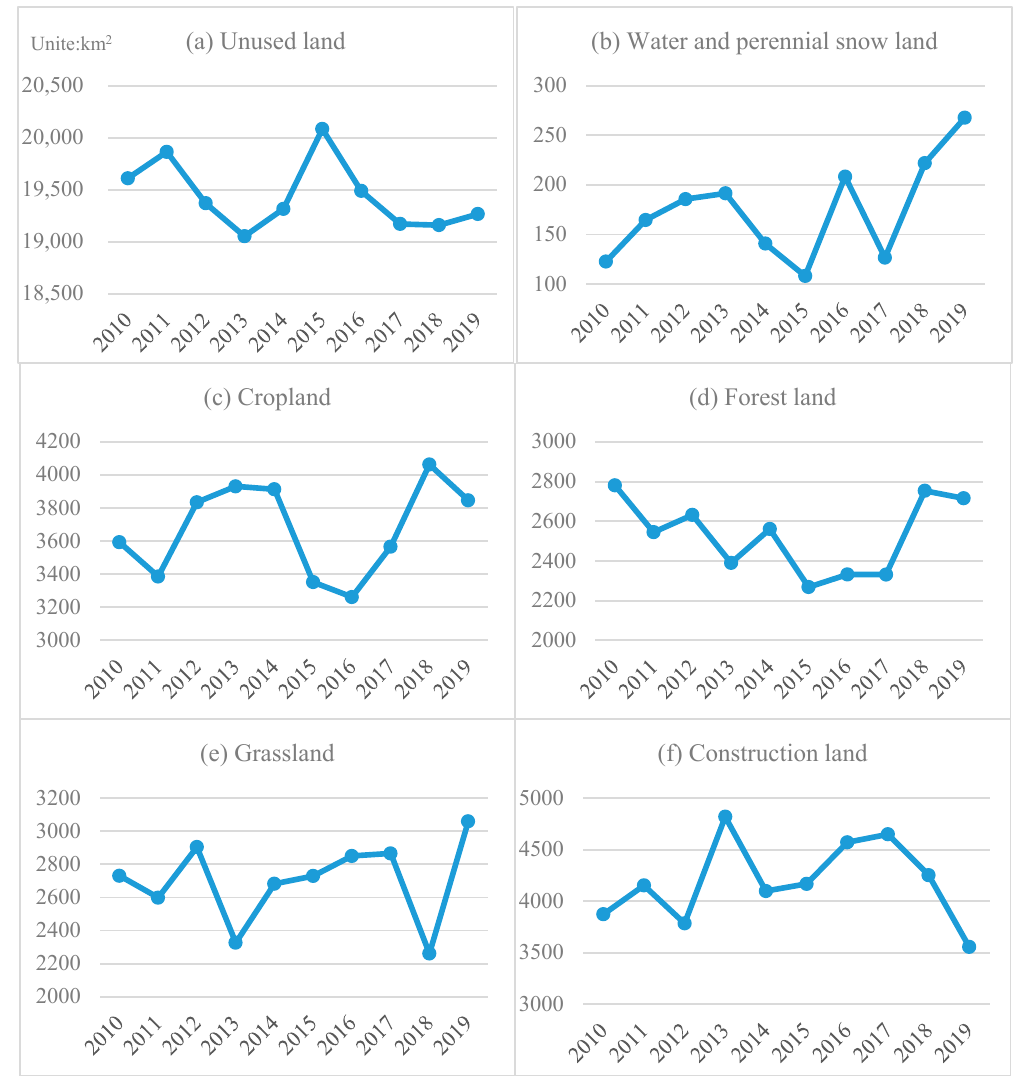
Figure 6. The changes of all classes area from 2010 to 2019.